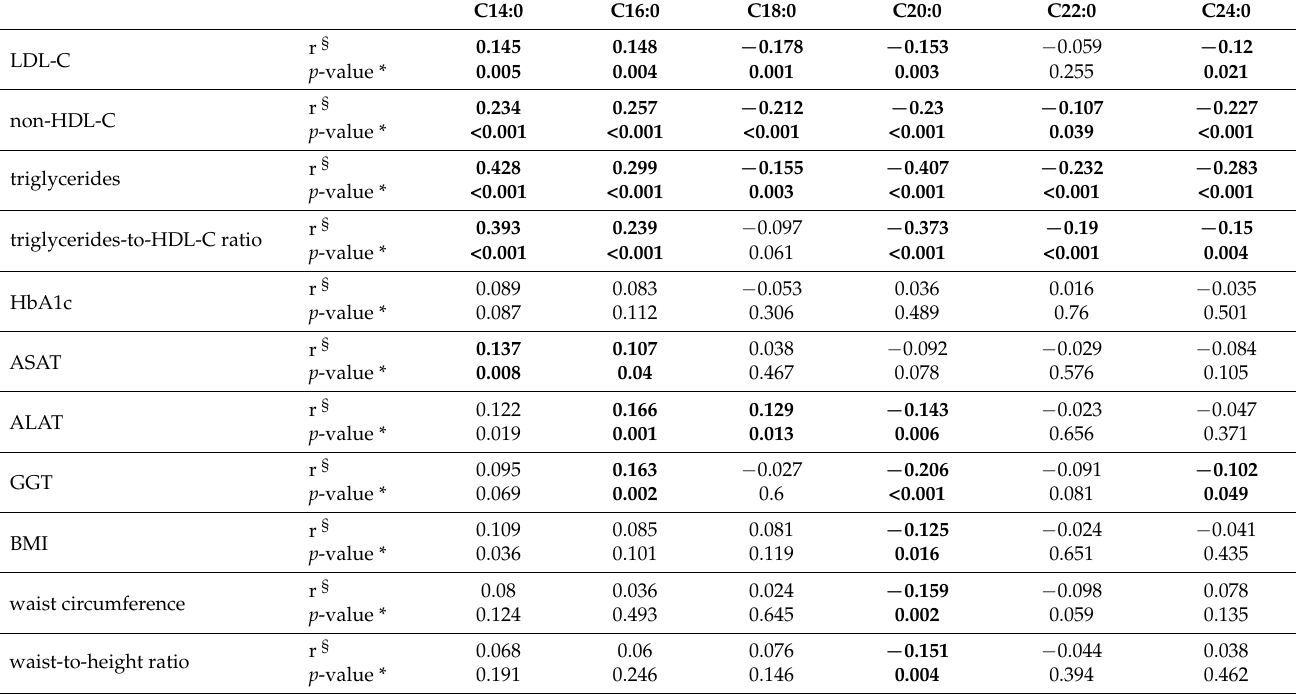
Table 2. Associations between individual SFA and patient characteristics at